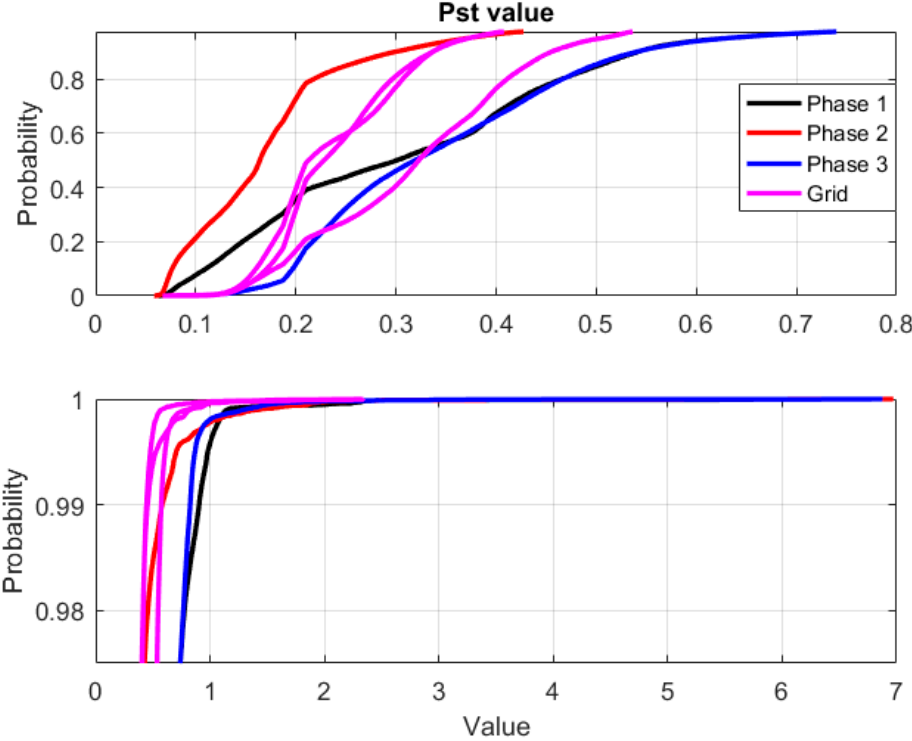
Figure 9. CDF for the Pst values for grid-connected and islanded operation where the interval 0 to 97.5% is displayed at the top and the remaining upper 2.5% is displayed in the bottom. The black, red and blue color represents phase 1 to 3 in islanded mode. Purple color represents all three phases during grid-connected operation. Table 4. 95% confidence interval, the maximum 10 min value and total average value for all three phases in islanded and grid-connected